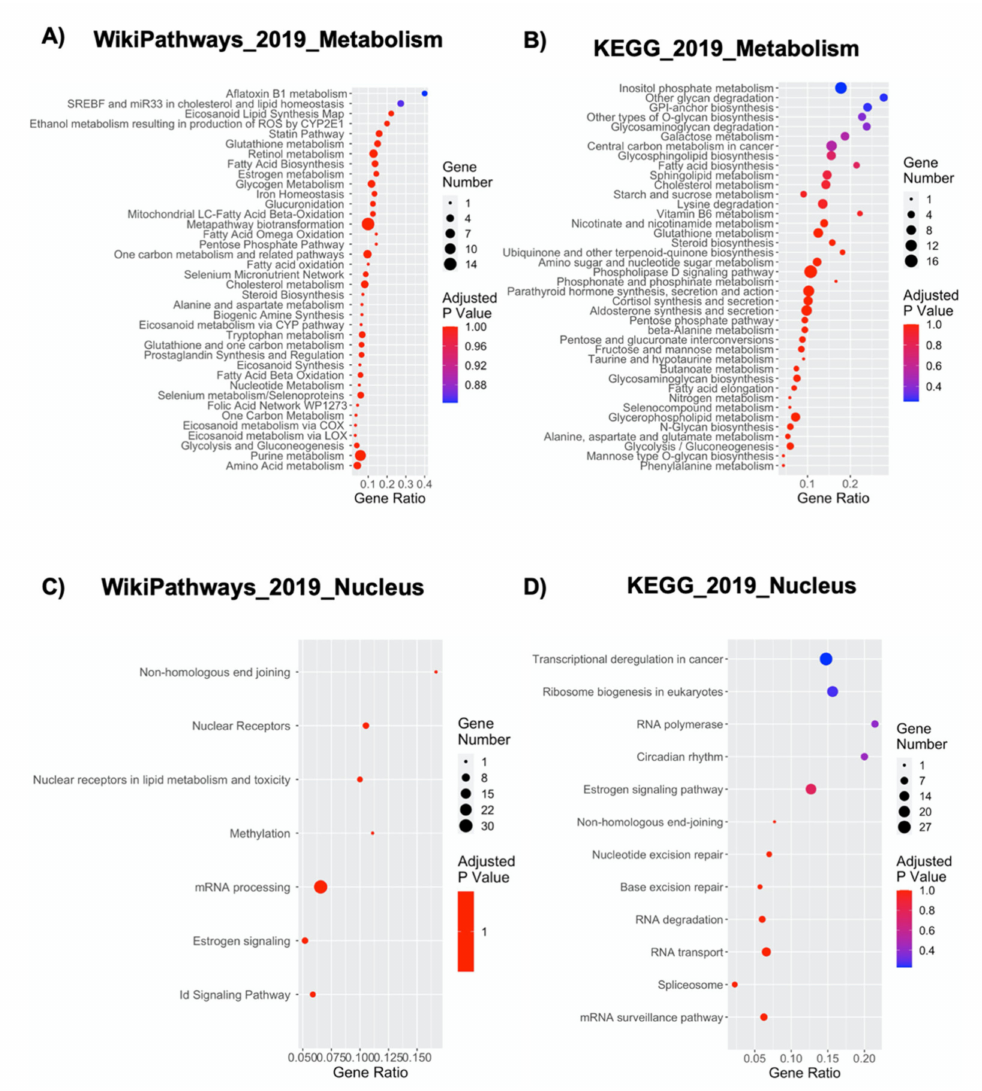
Figure 5. Deregulated pathways and genes correlated with metabolic alterations and nuclear response. WikiPathways analysis ( A ) and KEGG analysis ( B ) highlighted 38 and 68 deregulated pathways, respectively, for metabolic alterations. In panel ( B ) are shown the top 40 deregulated pathways. WikiPathways analysis ( C ) and KEGG analysis ( D ) highlighted 6 and 10 deregulated pathways, respectively, for nuclear response. The y-axis represents the name of the pathway, the x-axis represents the Rich factor, dot size represents the number of di ff erent genes, and the color indicates the adjusted p